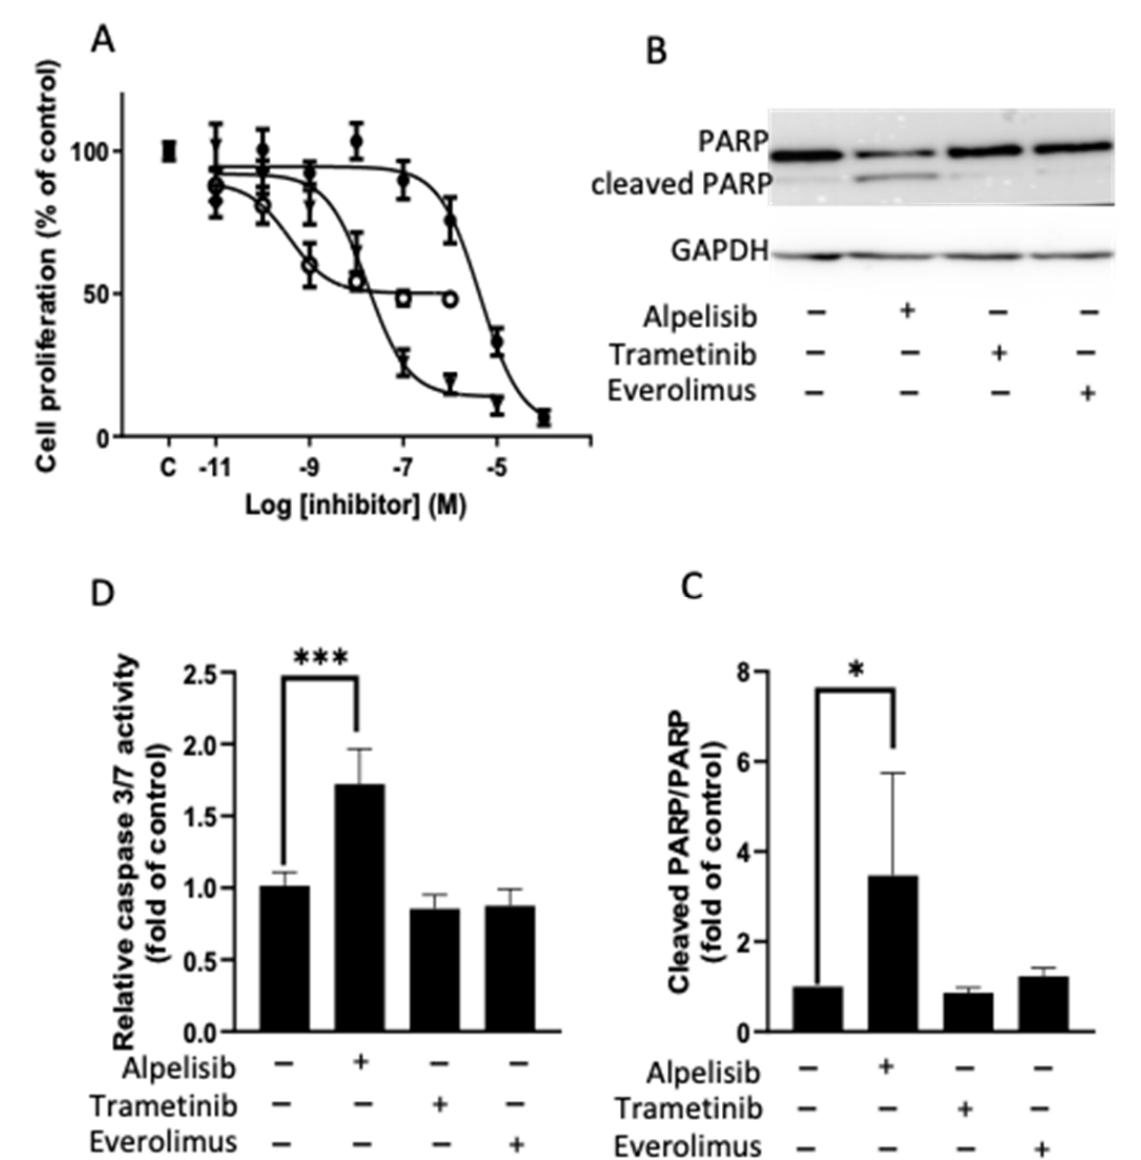
Figure 6. Mechanism of cell viability inhibition. ( A ): cell proliferation measured by BrdU incorpo- ration of 7 randomly selected meningiomas (see Supplemental Table S1) after 2 days’ of incubation period with an increasing dose of alpelisib (black points), trametinib (black triangles) and everolimus (white circles). Results are expressed as mean ± SEM percentage of BrdU incorporation in comparison to the control condition (“c” black square). PARP cleavage ( B , C ) and caspase 3/7 activities ( D ) in tumors in which alpelisib induced apoptosis. ( B ): a representative western-blotting of PARP cleavage on one meningioma (M8) after 2 days’ incubation period with alpelisib 10 − 6 M, trametinib 10 − 7 M, or everolimus 10 − 9 M. ( C ): the mean quantification of PARP cleavage on 4 meningiomas (M8, M11, M18, M30). Results are expressed as mean fold change ±SEM relative to control conditions * p < 0.05. ( D ): caspase 3/7 activity, after 2 days’ incubation period with alpelisib 10 − 6 M, trametinib 10 − 7 M or everolimus 10 − 9 M on M18, M24, M32, M33. *** p < 0.001 Results are expressed as mean fold change ±SEM relative to control cells. “+”: with the drug; “ − ”: without the drug. The original blots are shown in Supplementary Materials.